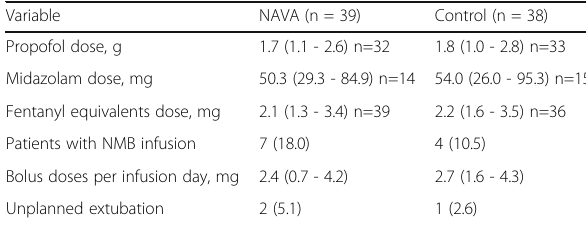
Table 2 (abstract 0052). Sedation load, number of neuromuscular blocker infusions and events associated with increased arousal and